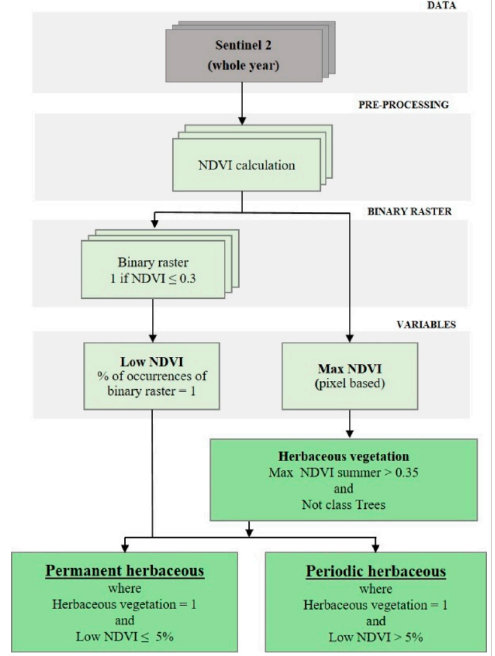
Figure A4. Workflow for herbaceous vegetation